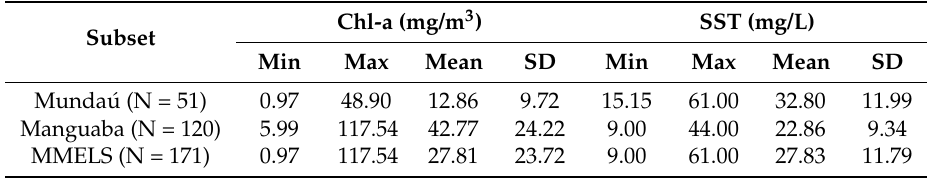
Table 3. Statistics of Chl-a and TSS concentration measured on the water samples collected in the MMELS.